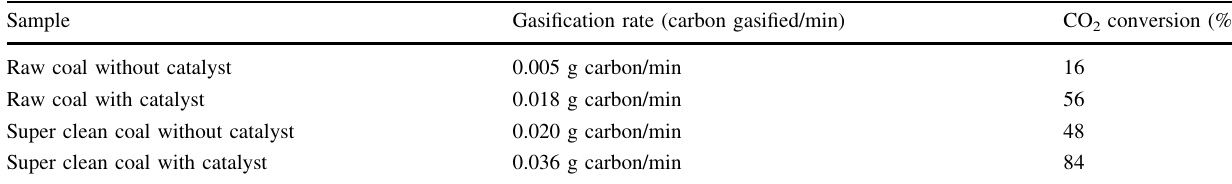
Table 4 Carbon conversion (gasification rate) and CO 2 conversion during CO 2 gasification